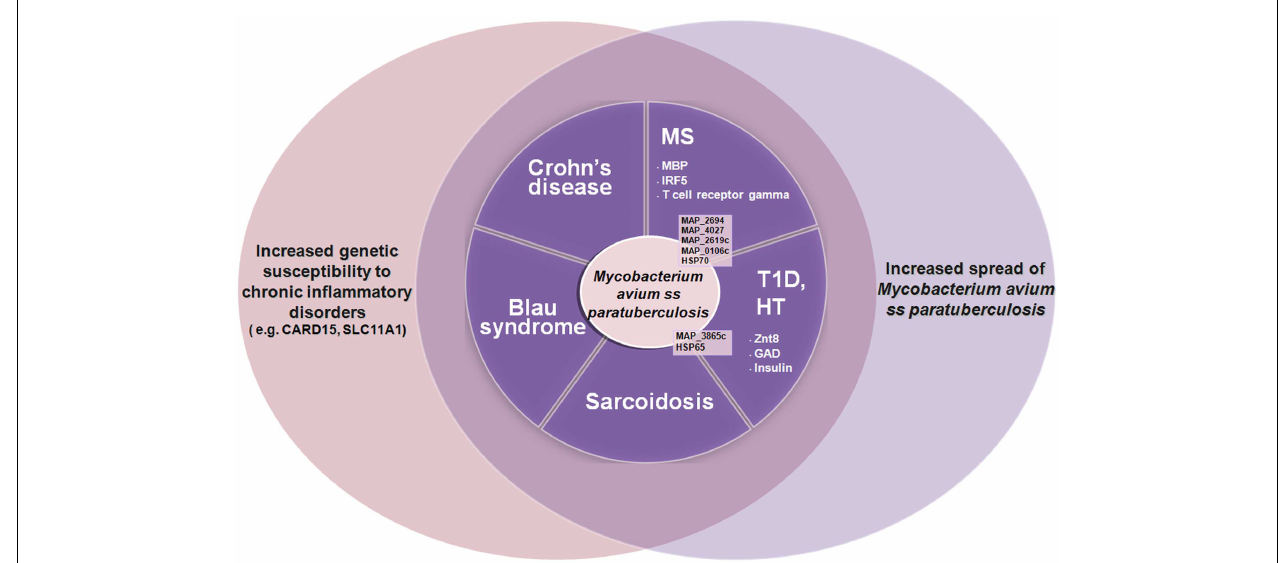
FIGURE 1 |The increased spread of Mycobacterium avium ss. paratuberculosis associated with genetic susceptibility to intracellular pathogens such as MAP (e.g., CARD15, SLC11A1) is leading to an increase of autoimmune diseases and inflammatory diseases such as